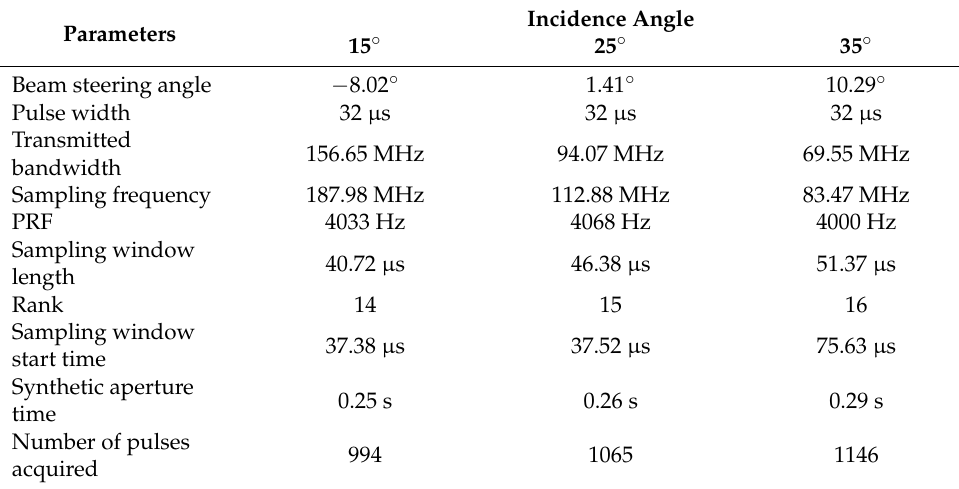
Table 5. Operational parameters of the S-STEP SAR payload in the wide-swath mode.